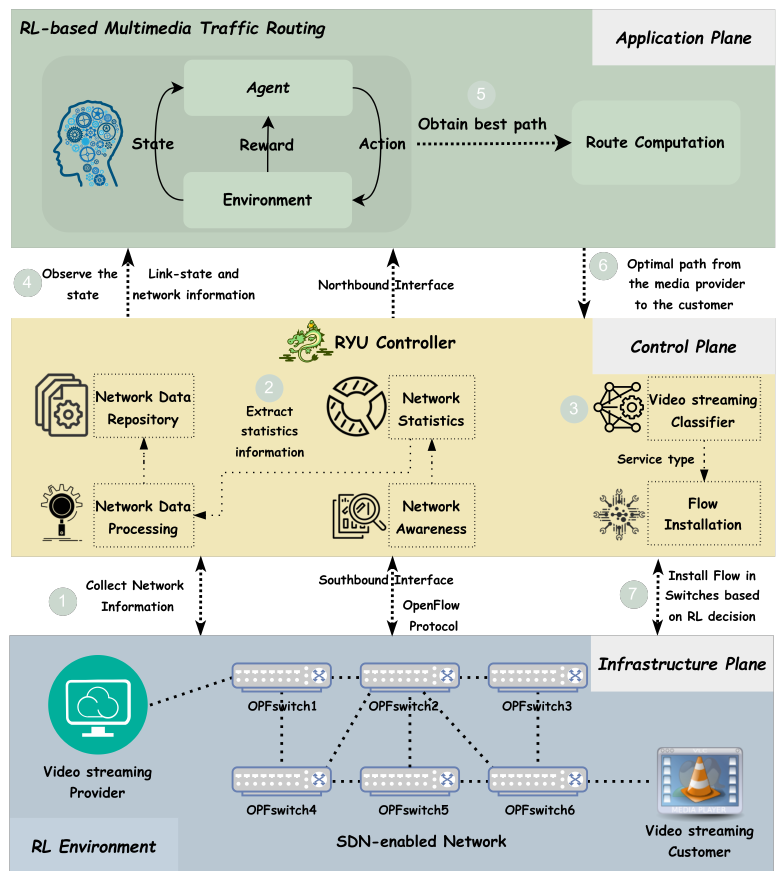
Figure 1. RL-based multimedia traffic routing